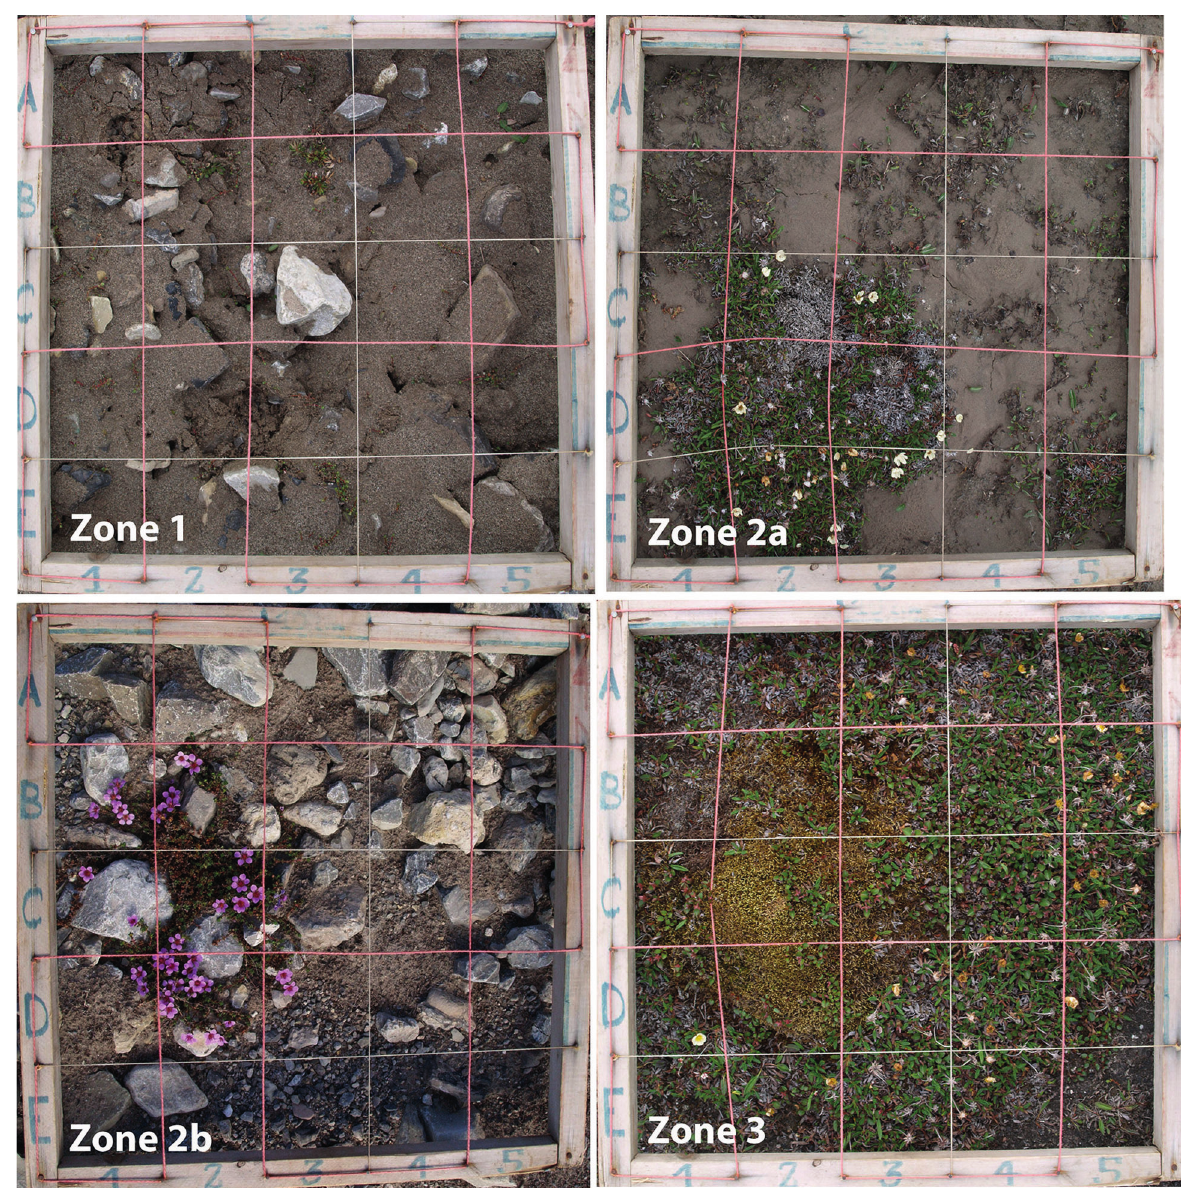
Fig. 2. Example of sample plots from delimited zones – differences in vegetation